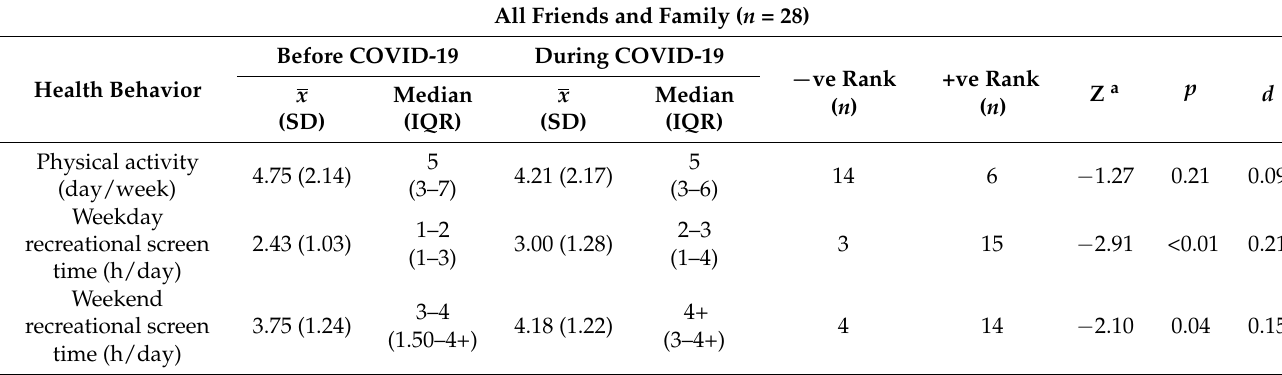
Table 6. Social interaction differences in children’s physical activity and screen time from before to during COVID-19. All Friends and Family ( n =